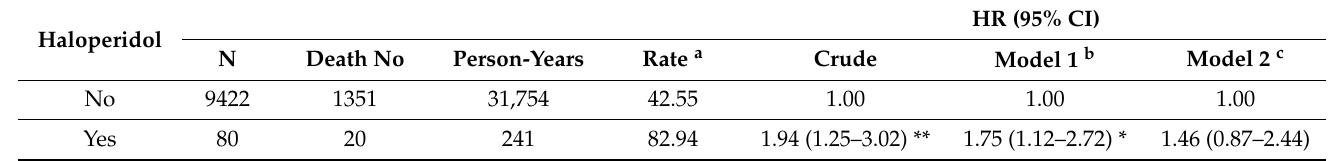
Table 1. Proportion of death among medicine use in endometrial carcinoma (N = 9502).